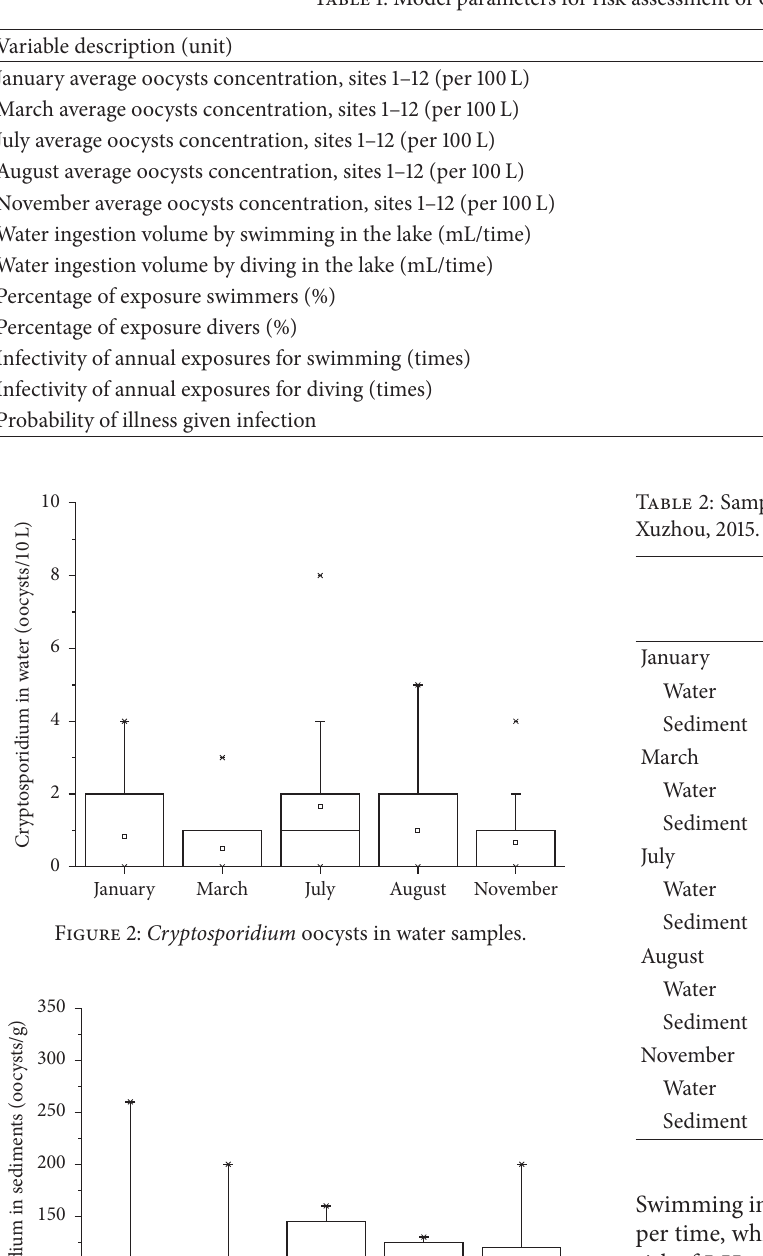
Table 1: Model parameters for risk assessment of Cryptosporidium.